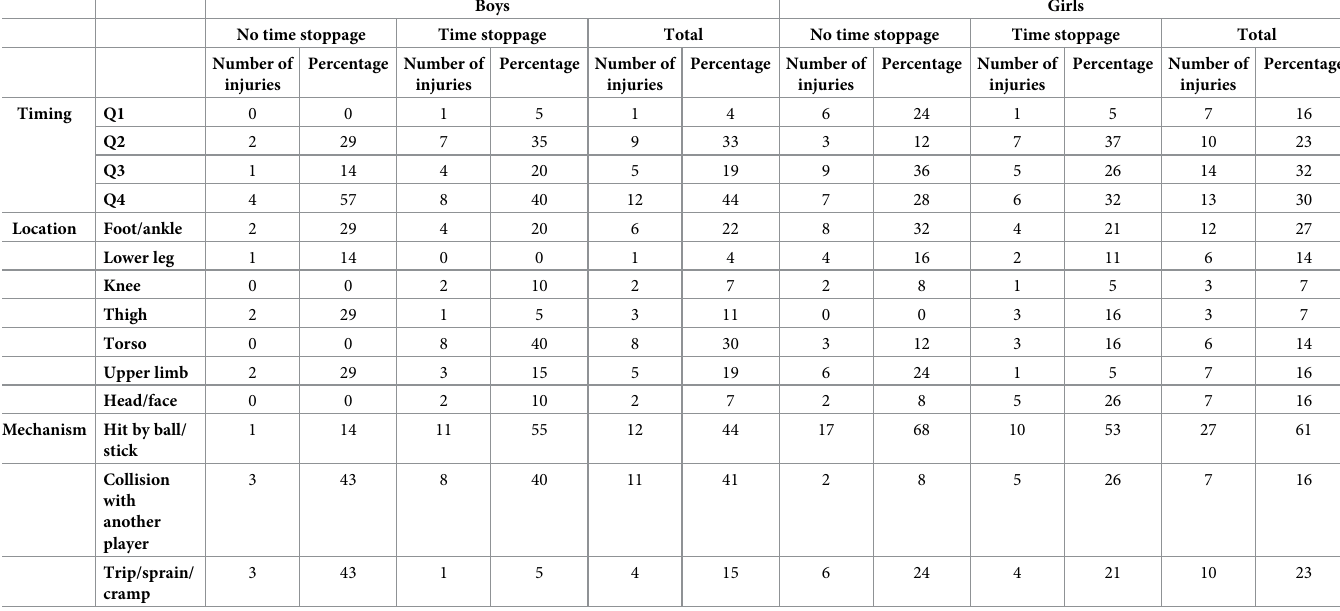
Table 2. Absolute and relative number of injuries in boys’ and girls’ competition: timing, location on body, and mechanism of